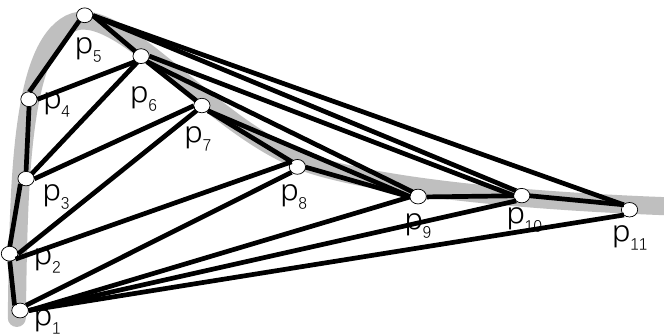
Figure 8. Constructing Delaunay Triangulation with representative points.